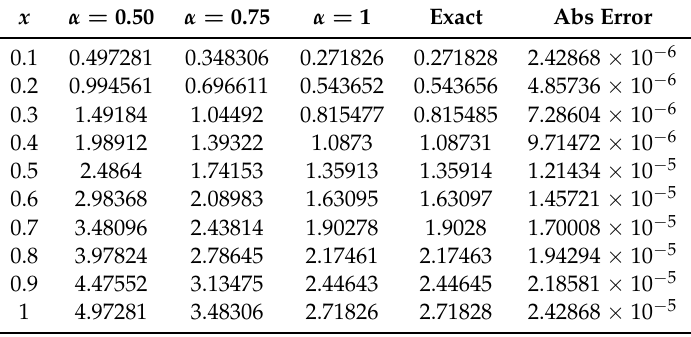
Table 15. Third order approximate results for different values of α at t = 1 of Example 3.